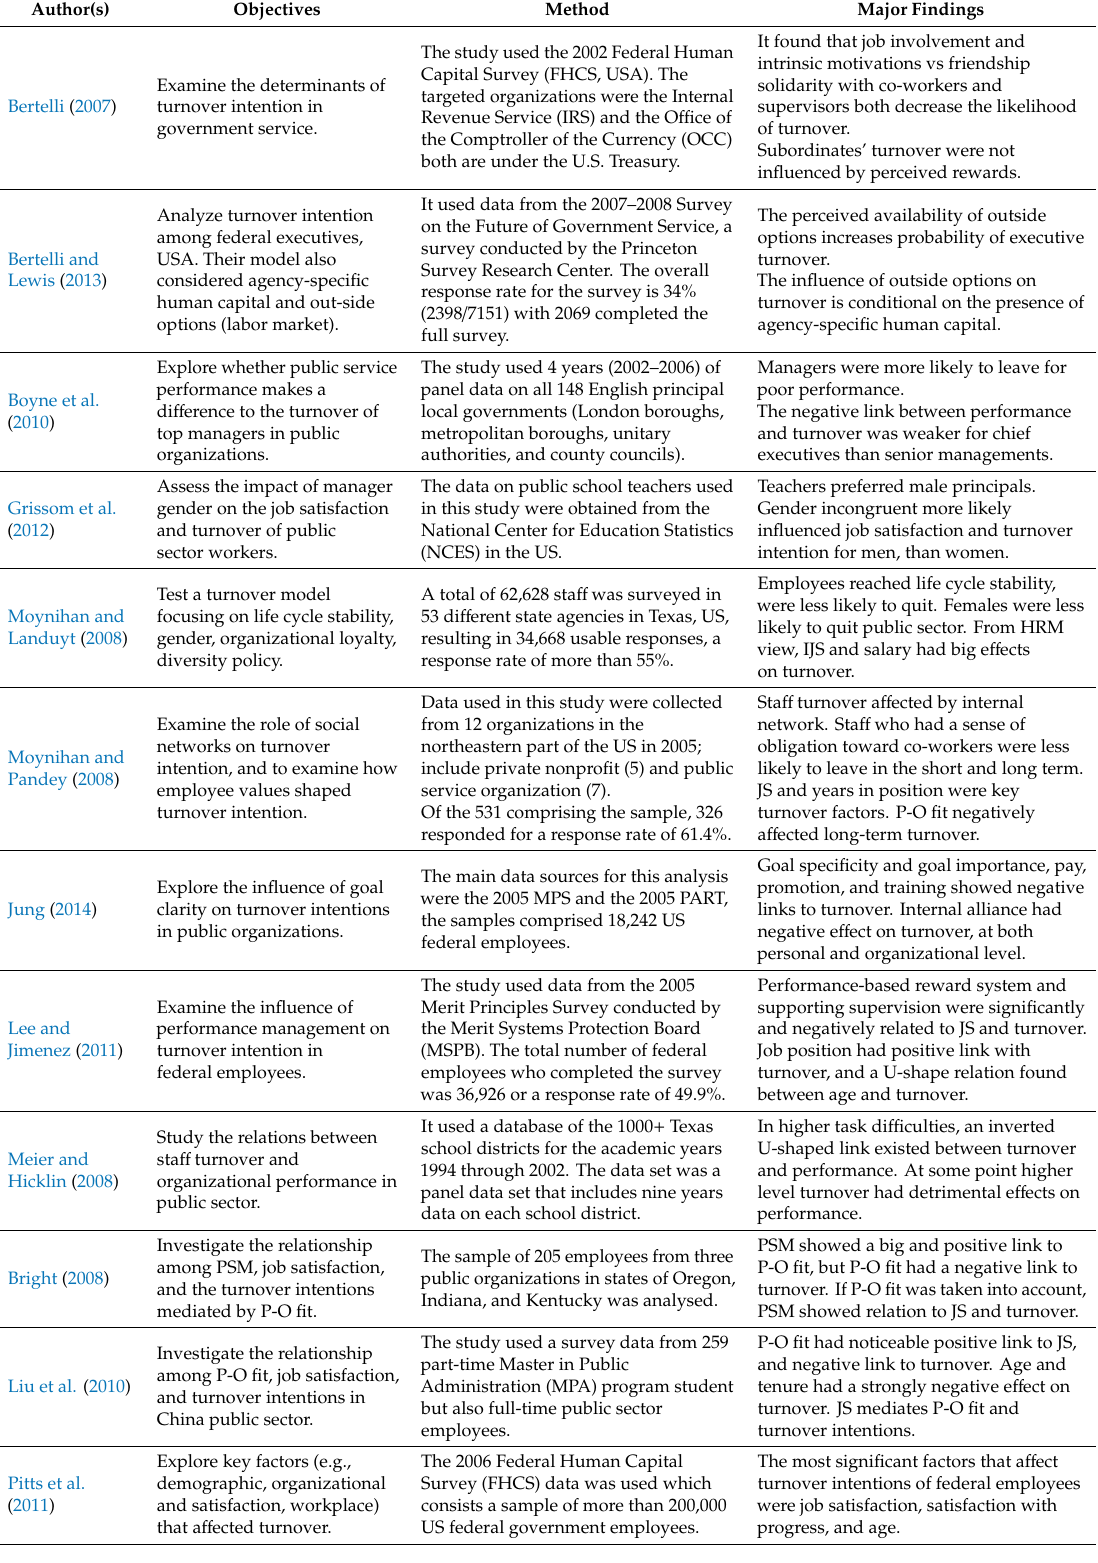
Table 2. Summary of research on turnover intention in public